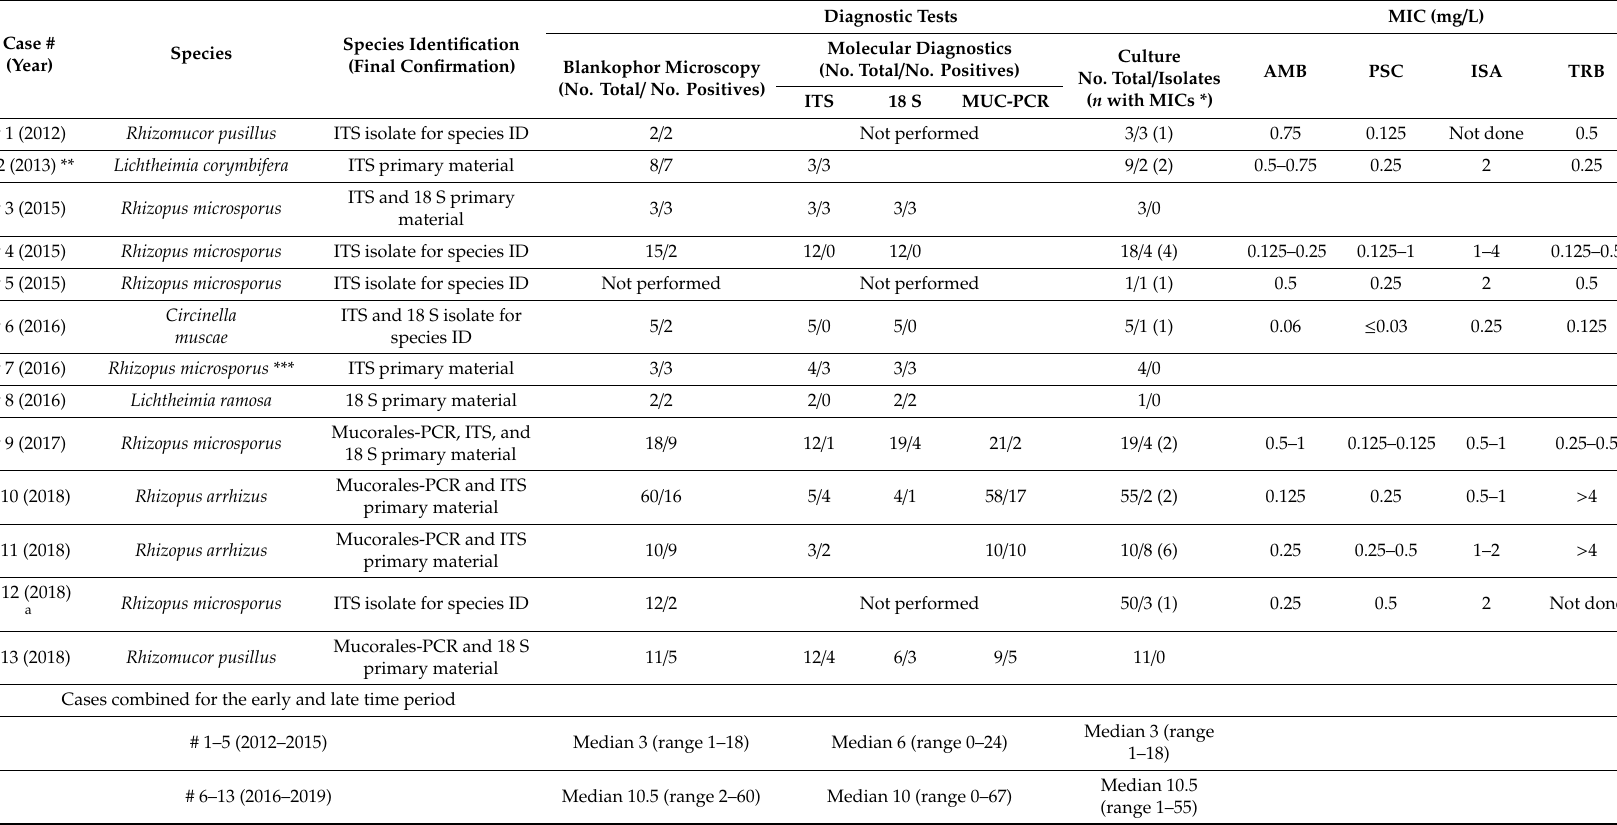
Table 2. Overview of microbiological characteristics and diagnostic tests including all samples from each patient received at the